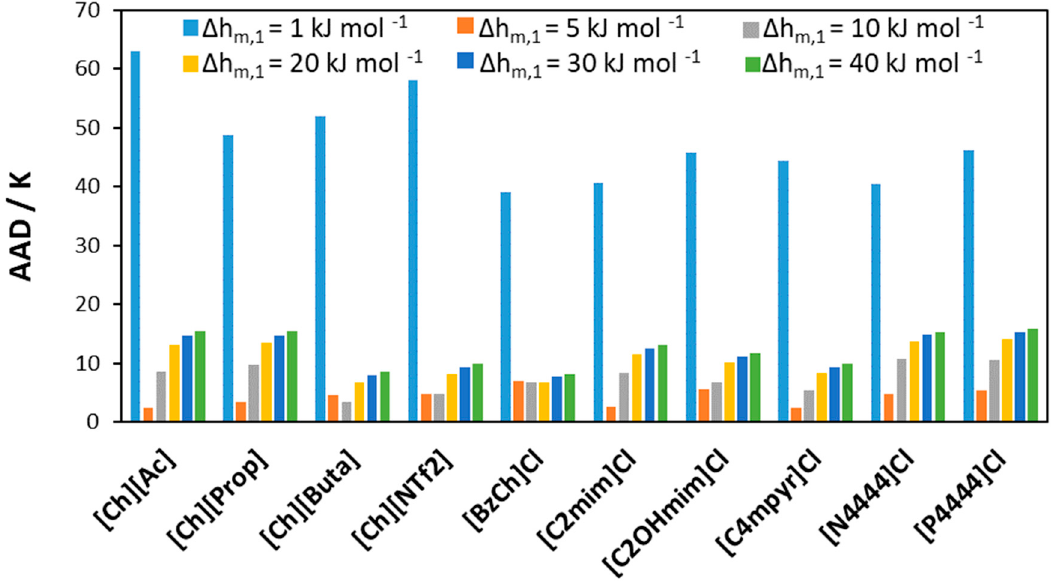
Figure 9. AAD between calculated and experimental liquidus temperatures for binary mixtures of [Ch]Cl and ILs assuming different melting enthalpies for [Ch]Cl.